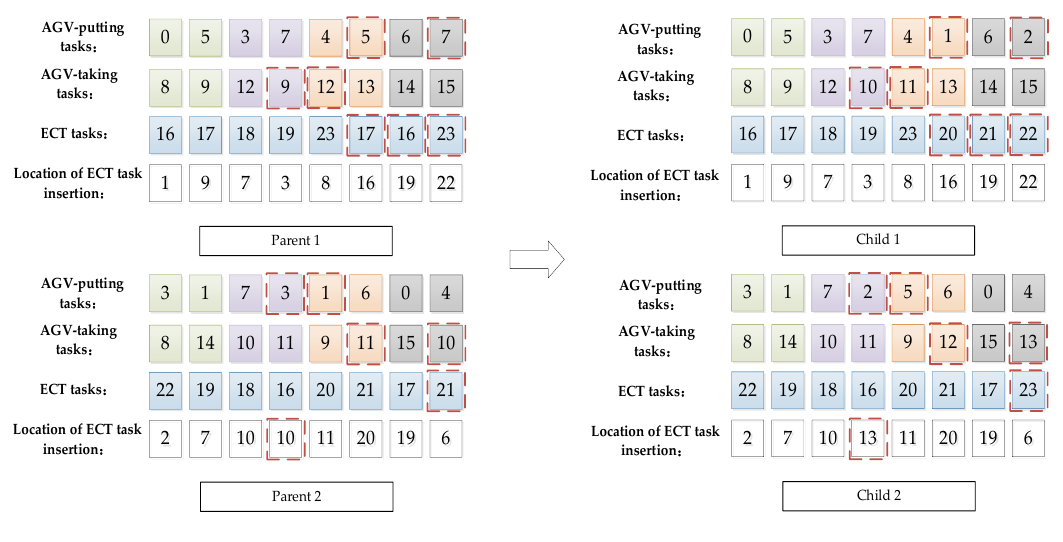
Figure 10. Repair the task sequence.